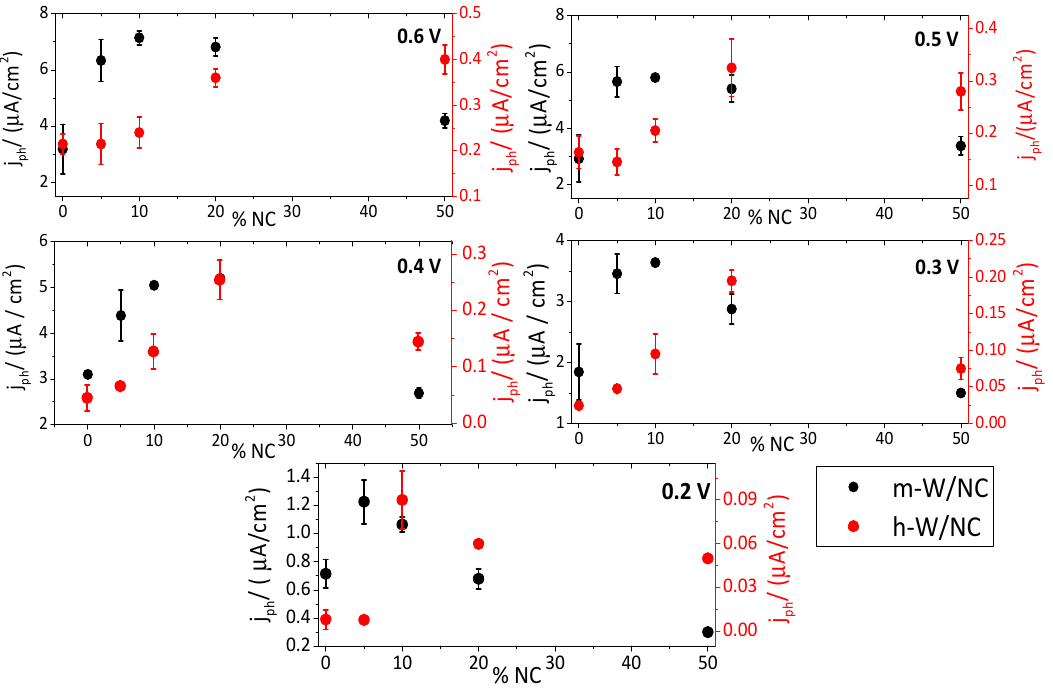
Figure 6. Photocurrent values for m-W/NC (black line) and h-W/NC (red line) electrodes as a function of the amount of nanoporous carbon for various applied potentials.